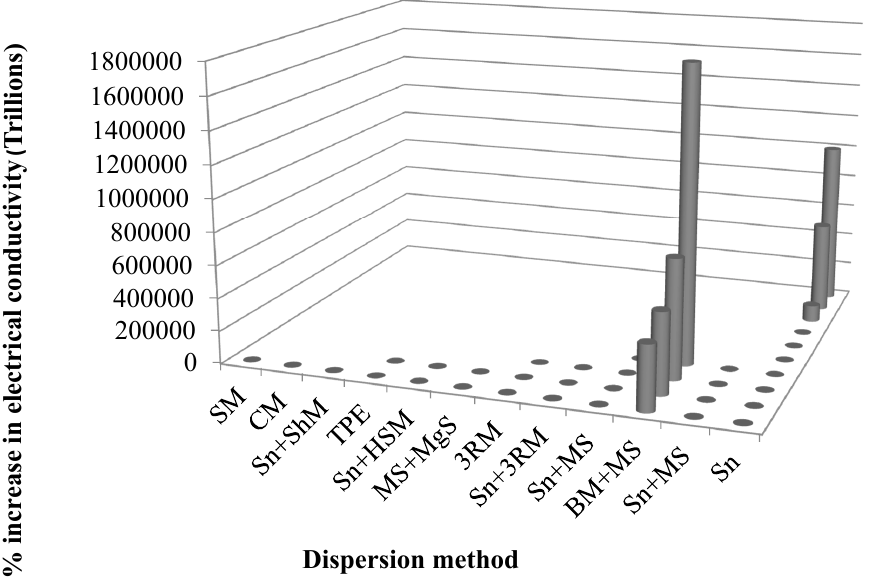
Figure 10. Percent increase in electrical conductivity as a function of dispersion method (see reference in Table 3).